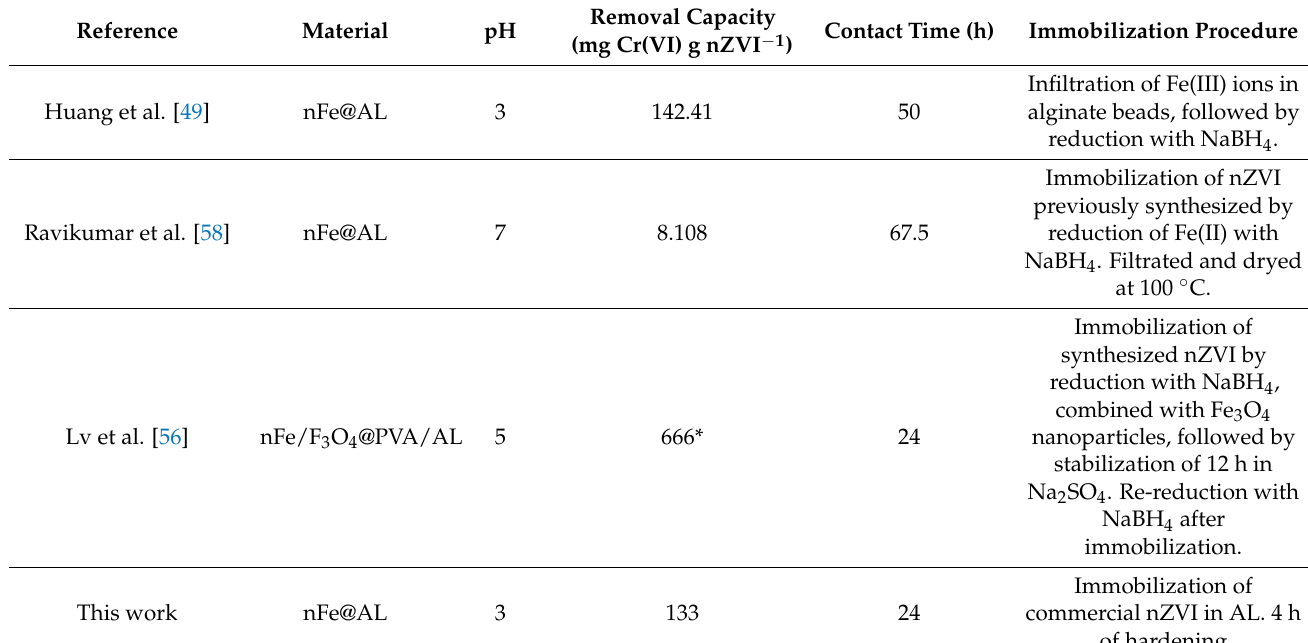
Table 1. Removal capacity of various materials based on nZVI@AL for the removal of